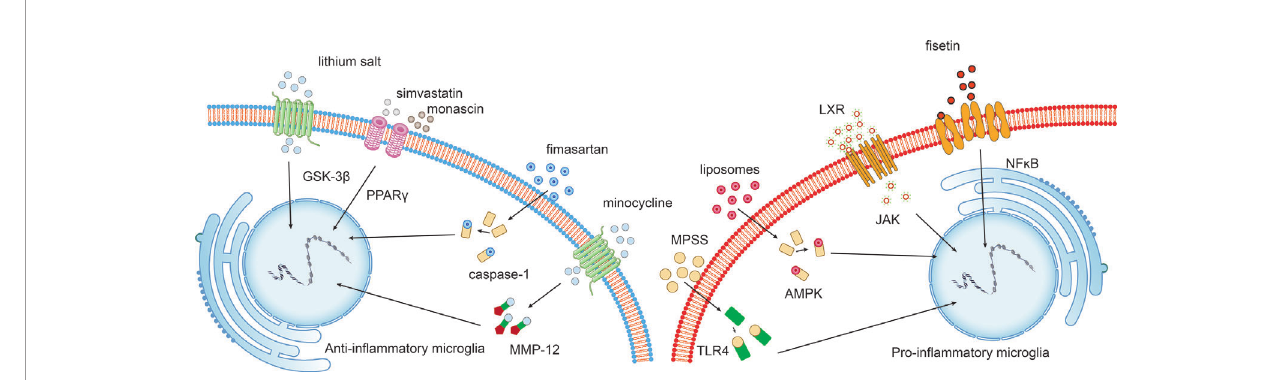
FIGURE 3 | Potential intervention strategies targeting the microglial phenotypic shift following ICH. Interventions that induce the polarization of pro-in fl ammatory microglia towards the anti-in fl ammatory phenotype exert bene fi cial effects following ICH. For example, fi setin mediates the NF k B pathway, and liver X receptor (LXR)- mediated JAK, liposome-mediated adenosine monophosphate-activated protein kinase (AMPK), and methylprednisolone sodium succinate (MPSS)-mediated TLR4 inhibit M1 microglia. While lithium salt mediates glycogen synthase kinase-3beta (GSK-3 b ) expression, simvastatin and monascin mediate peroxisome proliferator- activated receptor gamma (PPAR g ) levels, fi masartan mediates caspase-1 levels, and minocycline upregulates matrix metalloproteinase 12 (MMP-12)